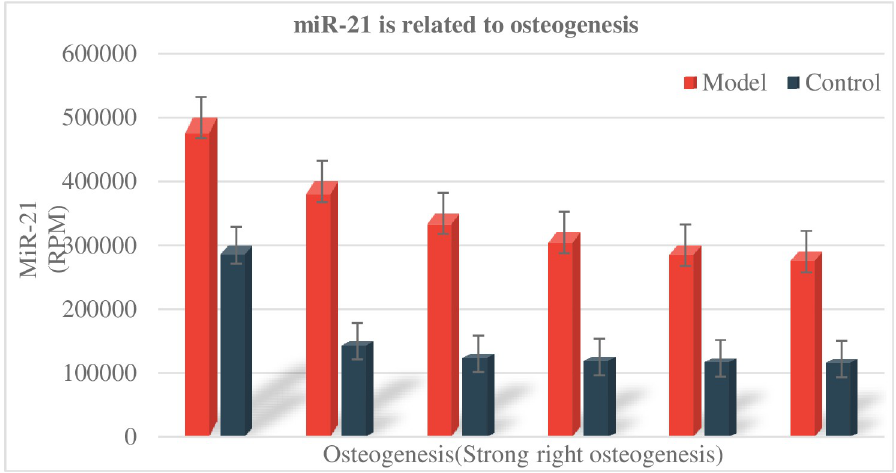
Fig 4. miR-21 is related to